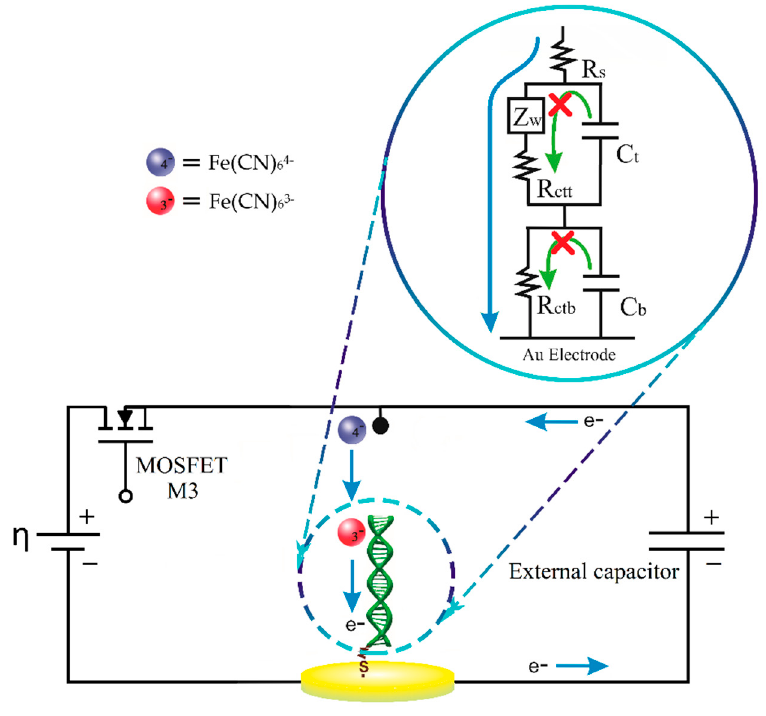
Figure 2. The electric current relaxation method.